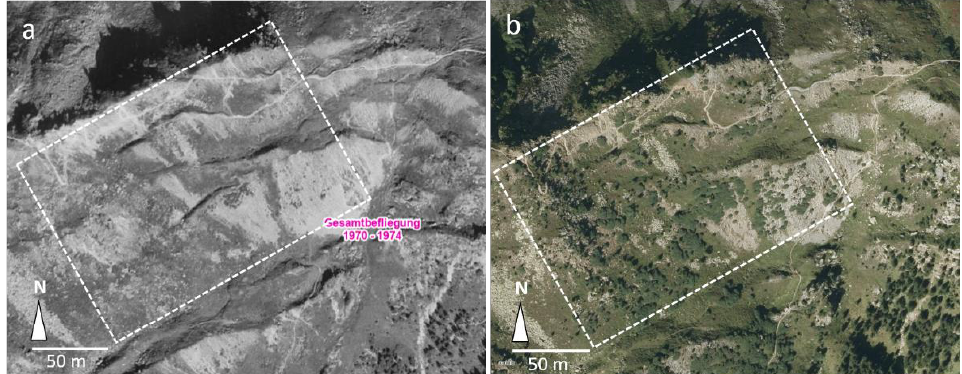
Figure 6. Example plot showing the spread of green alder ( Alnus alnobetula ) within the treeline ecotone on Mt. Patscherkofel. Orthophotos were taken in 1974 ( a ) and 2019 ( b ); elevation range: c . 2100–2200 m asl. The marked rectancle includes stands that were sampled in this study. Source: Orthophoto Land Tirol, tiris (https://lba.tirol.gv.at/public/karte.xhtml; 24 February 2022, and https://maps.tirol.gv.at/; 24 February 2022).